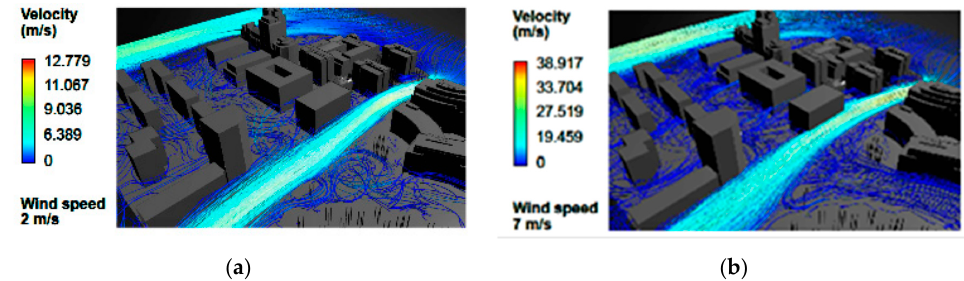
Figure 6. Wind flow analysis under west wind conditions. ( a ) Wind speed 2m/s, ( b ) wind speed 7m/s. Wind analysis proved that existing urban layout is favourable to use natural ventilation solutions. Both building location and the neighbourhood of two major streets show a high ventilation potential for the northern and eastern elevations. Sun radiation analysis indicates that these elevations are shadowed, and may be used as part of a natural ventilation system.